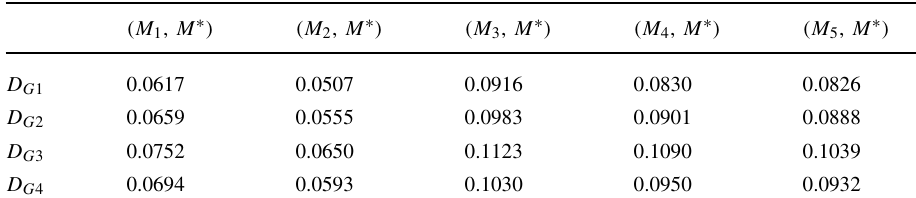
Table 10 Computed values of the distance of each alternative from the PF ideal solution